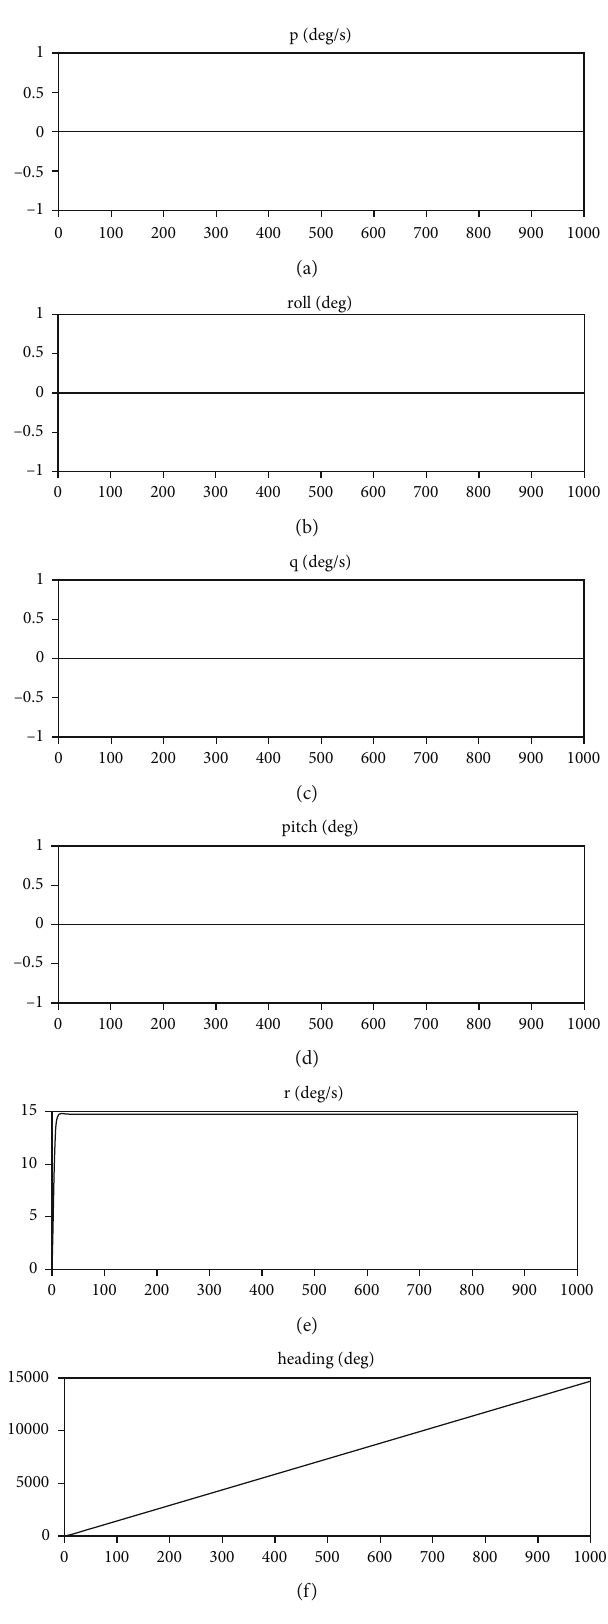
Figure 14: The relationship between angular velocity, rotation angle, and simulation time: (a) angular velocity u ; (b) angular velocity v ; (c) angular velocity w ; (d) roll angle; (e) pitch angle; (f) heading